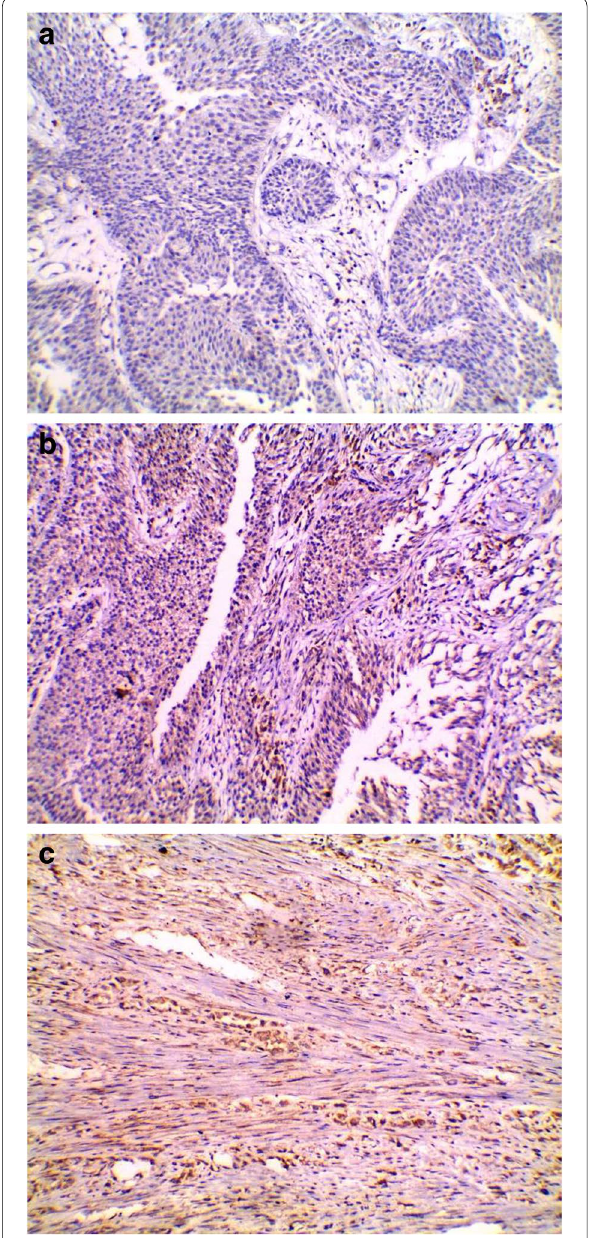
Fig. 2 Immunohistochemical expression of FAP ( FAP expression in cancer‑associated fibroblasts (CAFs) in low‑grade pT a UC, b high FAP expression in CAFs in low‑grade pT 1 UC, and c high FAP expression in CAFs in high‑grade pT 2